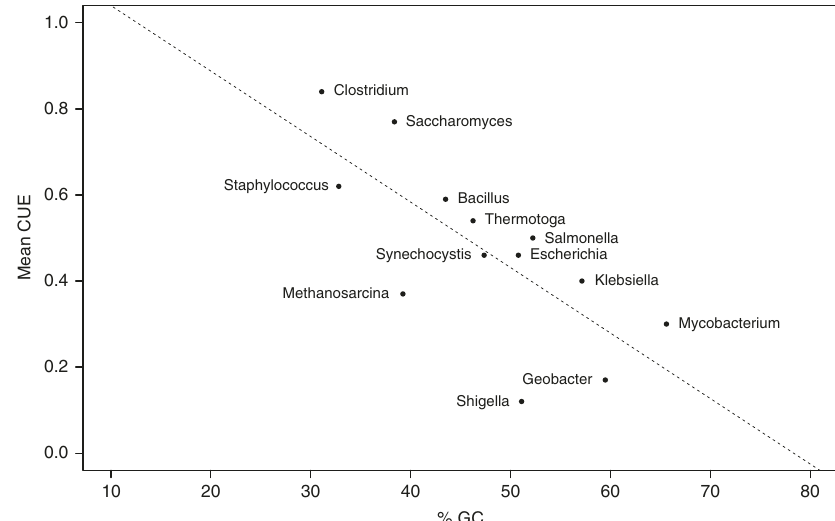
Fig. 4 Mean CUE versus GC content. Mean CUE versus GC content for manually curated metabolic models. Species in order of increasing GC content are Clostridium ljungdahlii DSM 13528 , Staphylococcus aureus subsp. aureus N315 , Saccharomyces cerevisiae S288c , Methanosarcina barkeri str. Fusaro , Bacillus subtilis subsp. subtilis str. 168 , Thermotoga maritima MSB8 , Synechocystis sp. PCC 6803 , Escherichia coli str. K-12 substr. MG1655 , Shigella boydii Sb227 , Salmonella enterica subsp. enterica serovar Typhimurium str. LT2 , Klebsiella pneumoniae subsp. pneumoniae MGH 78578 , Geobacter metallireducens GS-15 , Mycobacterium